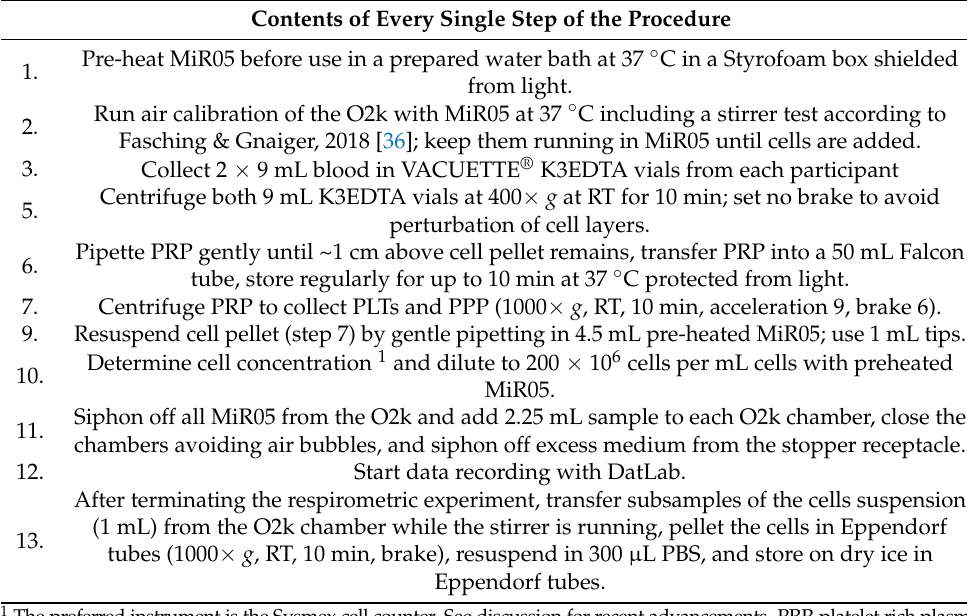
Table 4. Protocol for sample and simultaneous O2k